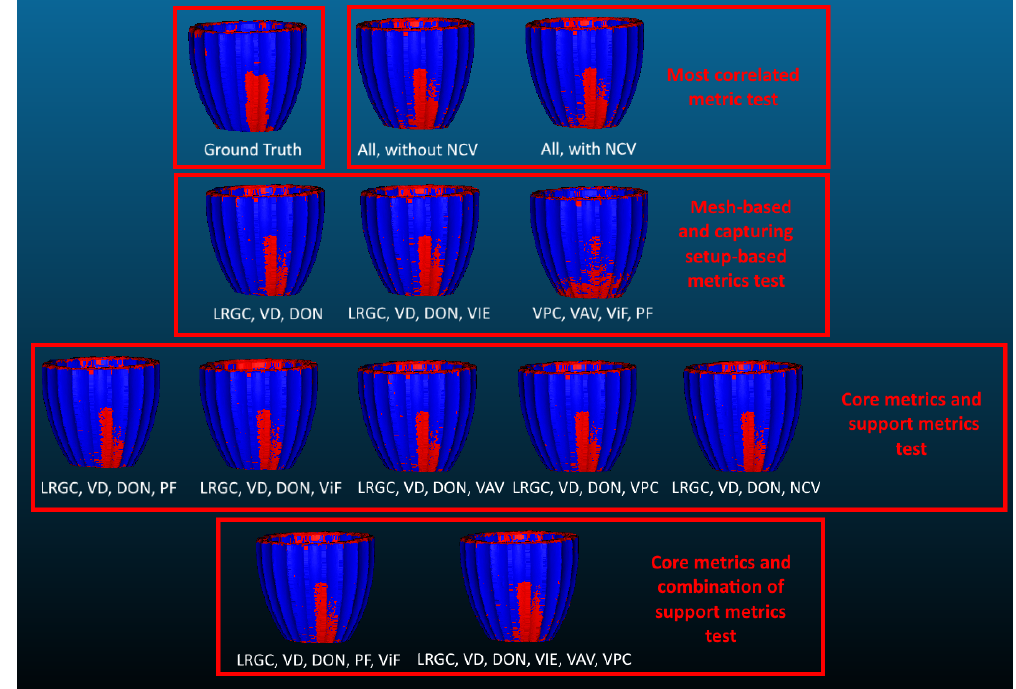
Figure 13. Visualization of the noise estimation results, using different subsets of metrics, together with the ground truth annotation. The different testing scenarios are separated for easier